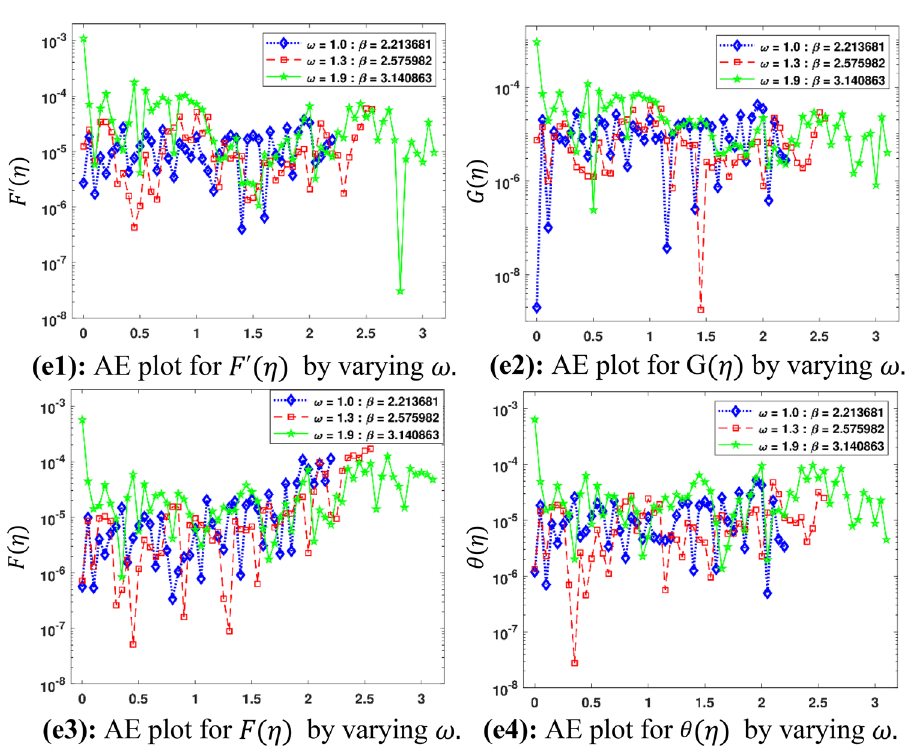
Figure 11. AE plots for outputs by proposed scheme and reference